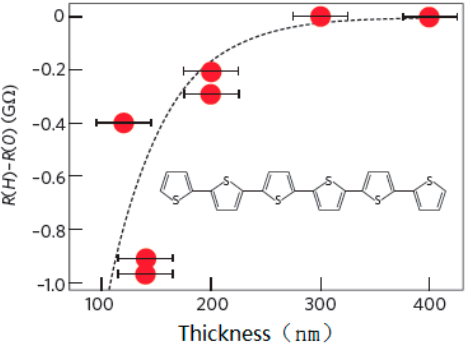
Figure 3. Relation between magnetoresistance (MR) and T6 thickness.